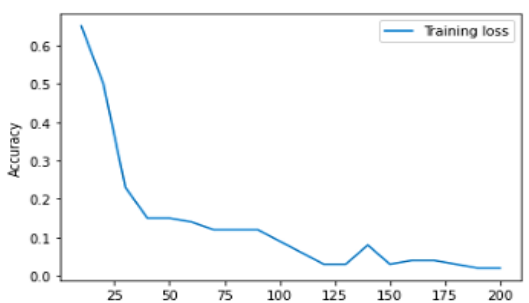
Figure 9. Training and validation learning curve.